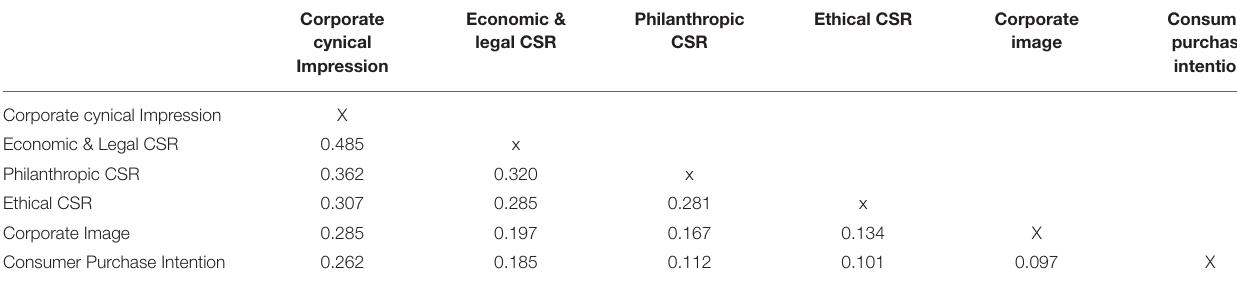
TABLE 5 | Heterotrait-monotrait ratio of correlations (HTMT) analysis.